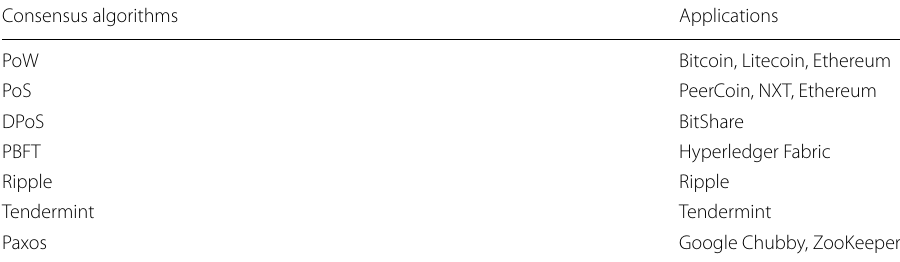
Table 1 Typical applications of consensus algorithms Consensus